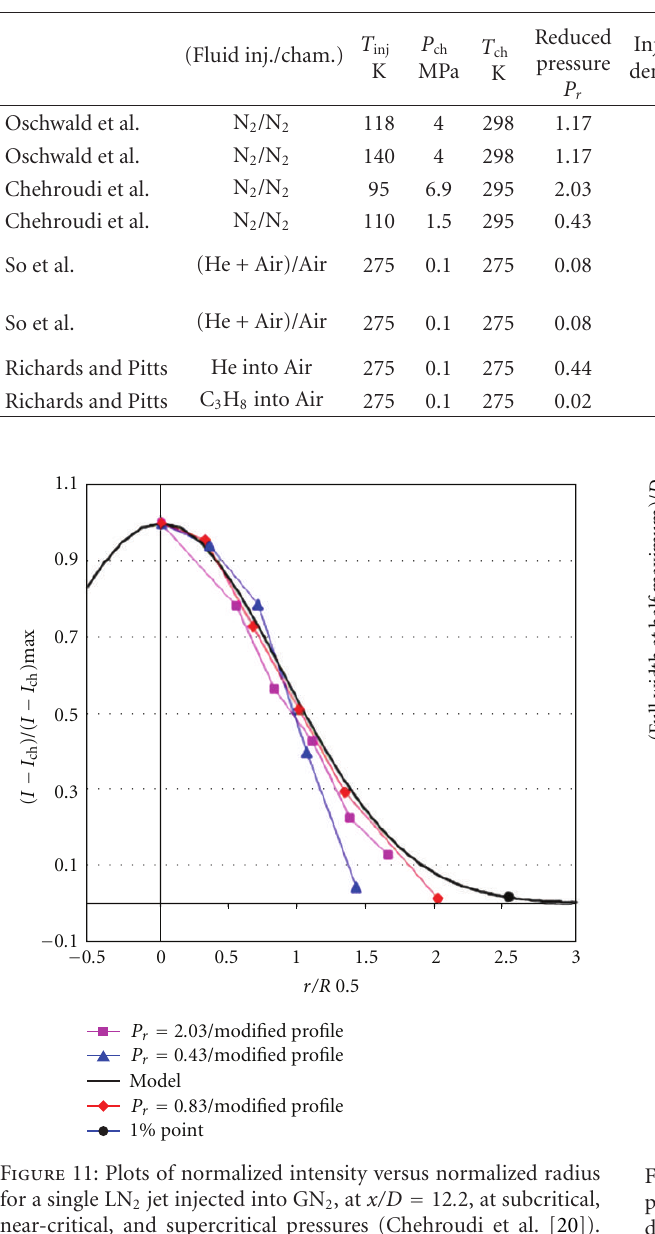
Table 1: Some information extracted from works by other investigators reported here. T inj and T ch are injection and chamber temperatures. P ch is chamber pressure. L/D is the injector hole-to-diameter ratio, x/D is the normalized distance from injector exit within which measurements were made. Chehroudi et al. [20].